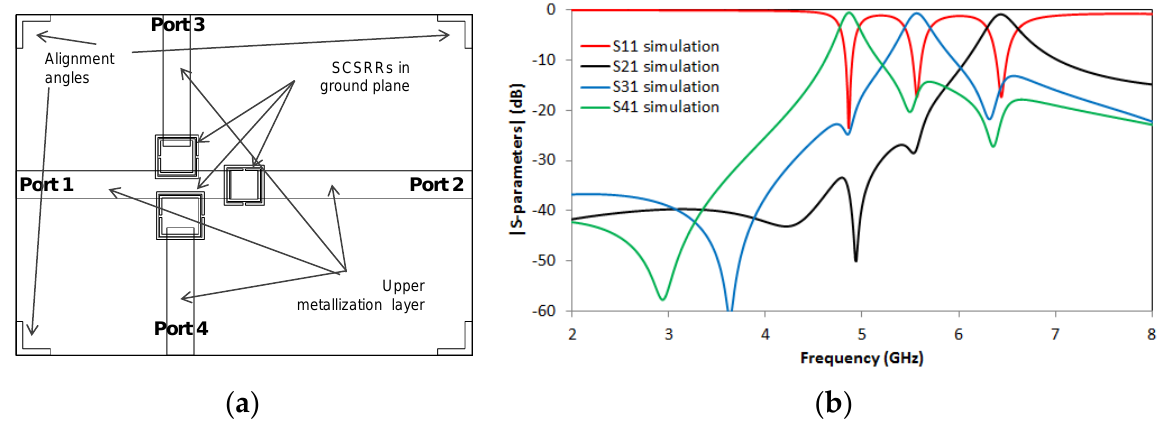
Figure 28. ( a ) Top view overlapped layer distribution of 2-layer triplexer, which is SCSRR based. All